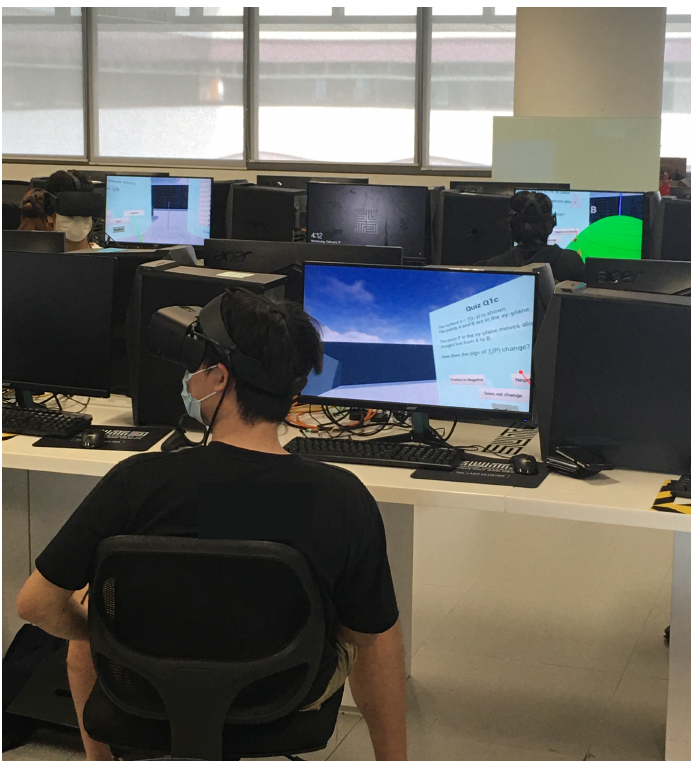
Figure 2. Students participating in the treatment test at their own pace. Computer screen gives a perspective of what the student is observing in the VR headset.